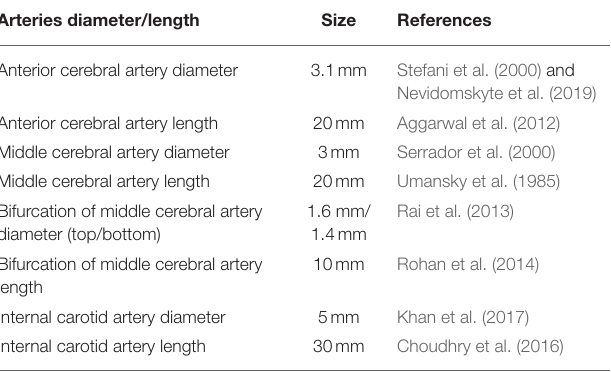
TABLE 1 | The diameter and length for cerebral artery